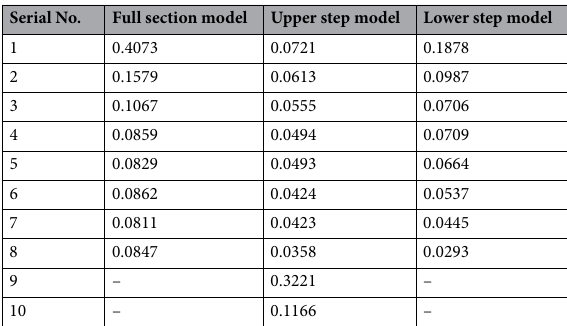
Table 7. Statistics of peak vibration velocity of each monitoring point (units: m/s).